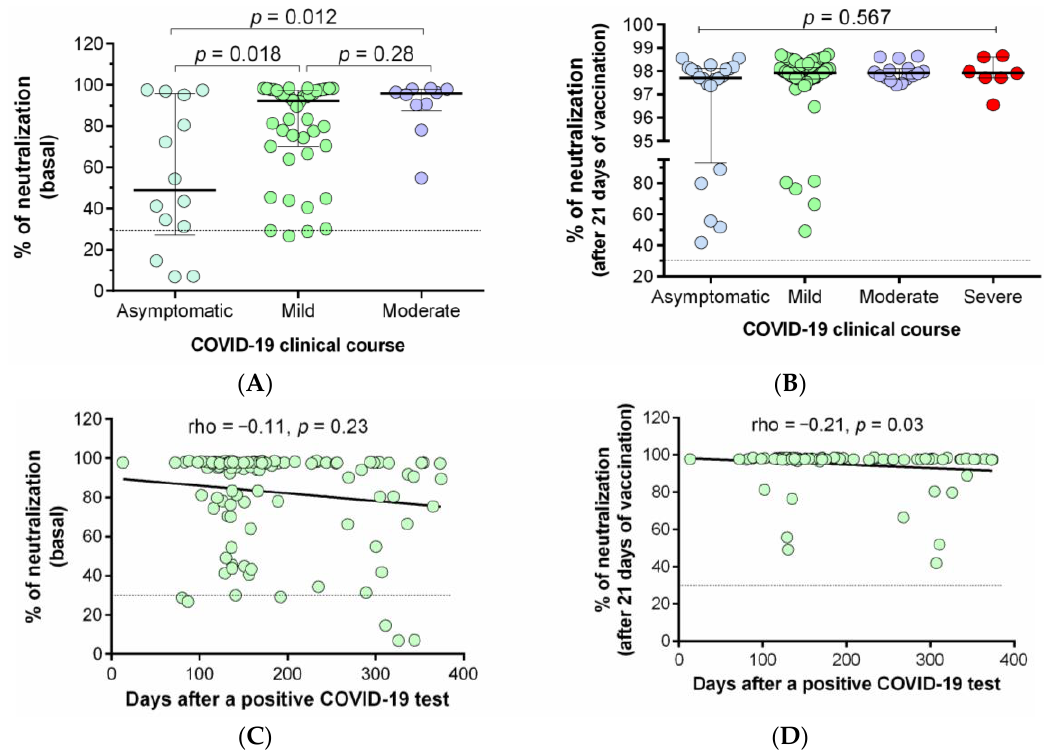
Figure 3. Relationship between prior COVID-19 clinical course and days after infection with the percentage of neutralization. ( A ) Comparison of basal neutralization percentage between individuals with different prior COVID-19 clinical courses; ( B ) comparison of neutralization percentage after 21 days of immunization with the Ad5-nCoV vaccine among individuals with different prior COVID-19 clinical courses. Correlation between percentage of neutralization and the time of a previous COVID-19 infection: ( C ) Basal neutralization percentage, and ( D ) neutralization percentage after 21 days of the vaccination. The difference between all groups was calculated with the Kruskal–Wallis test, followed by the U-Mann–Whitney test. Data are provided as median and interquartile ranges.